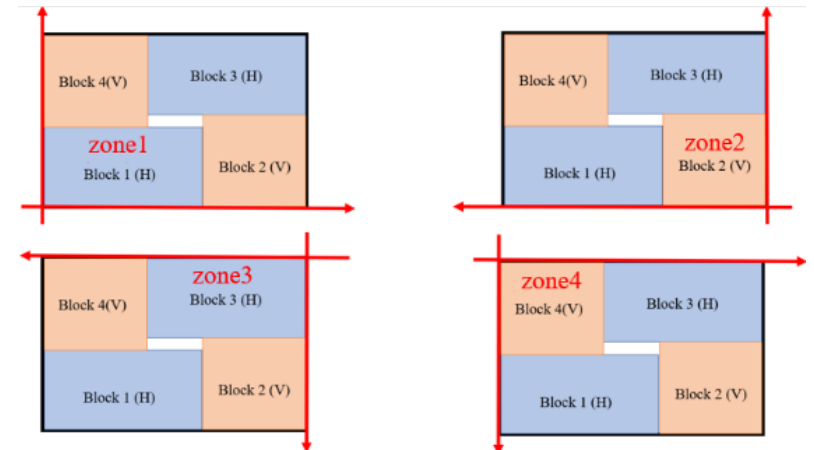
Algorithm 2. Non-overlapping coordinate calculation